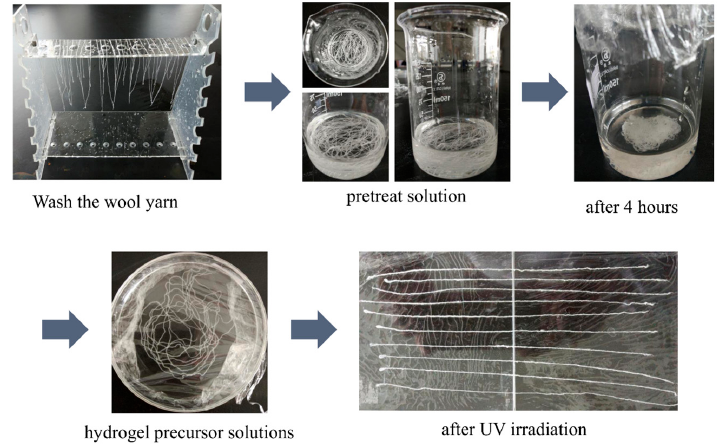
Figure 2. The procedure of wool keratin yarns coated by hydrogel precursor: from preparation of wool yarns to polymerization reaction (UV irradiation).